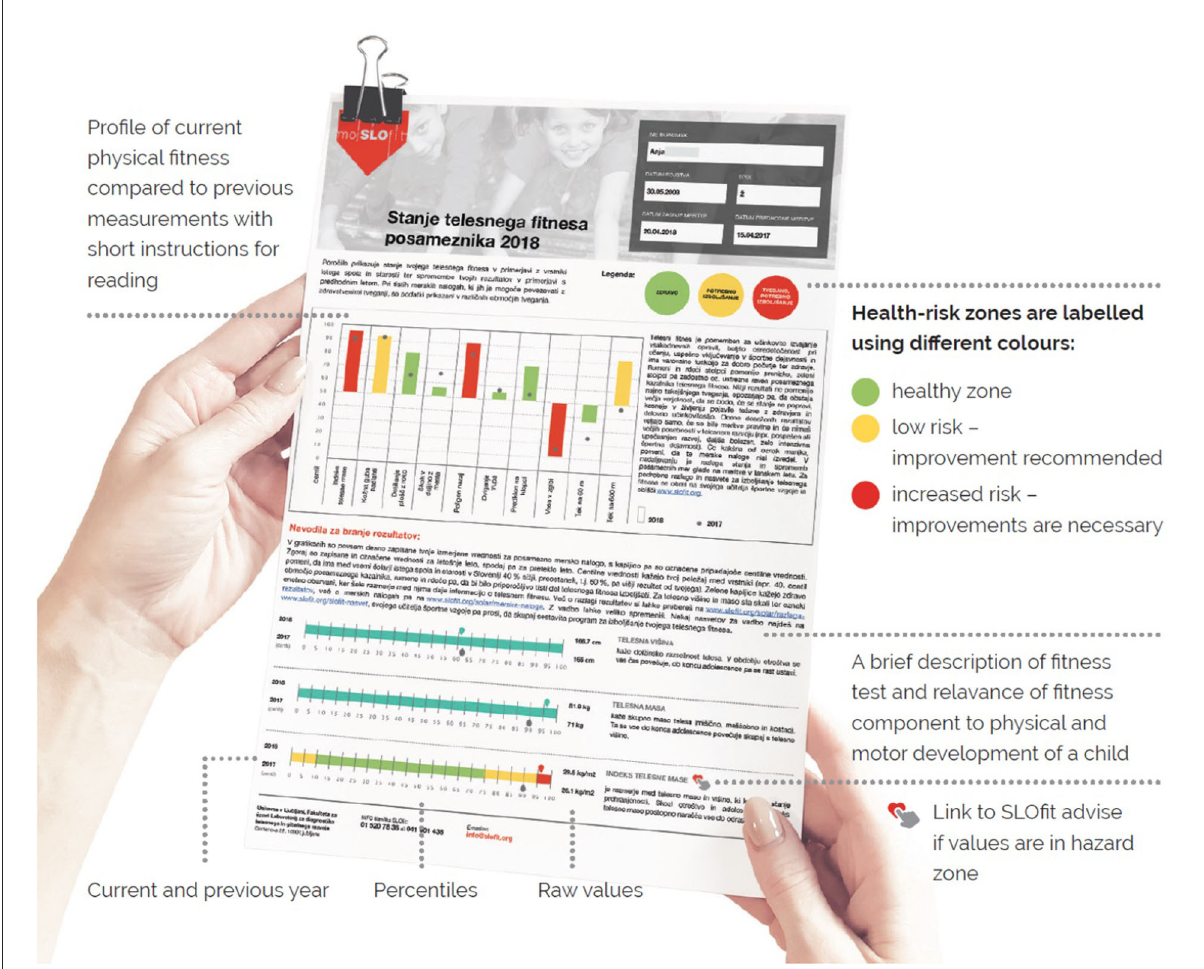
FIGURE1 SLOfit Lifelong health risk feedback report example. The free-of-charge My SLOfit app provides all registered users with official SLOfit reports that specify healthy fitness outcomes, centiles, and participant histories. SLOfit reports help facilitate better and more concise